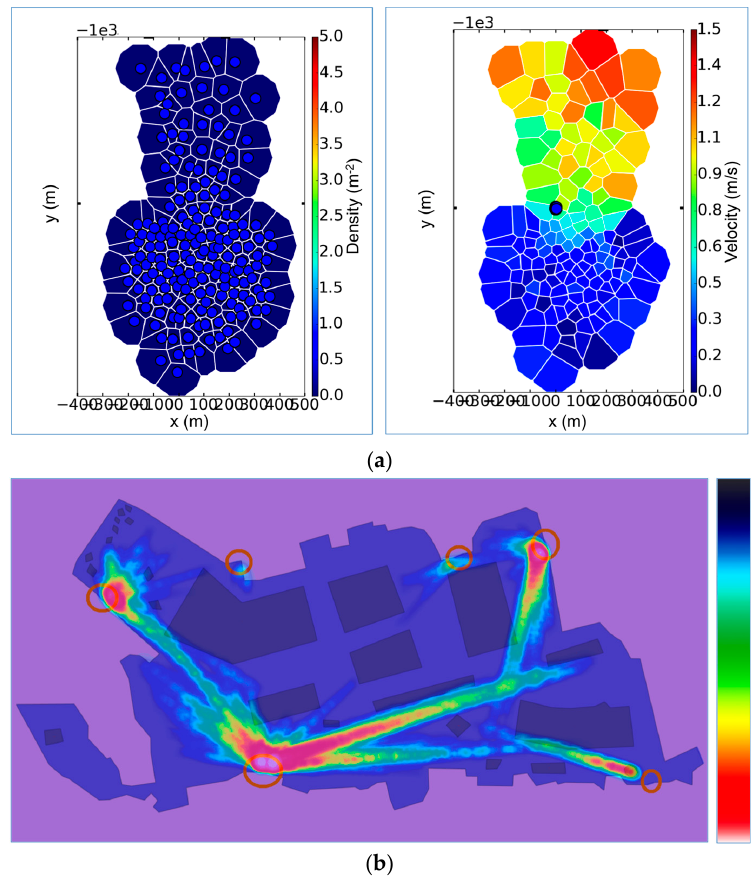
Figure 7. The output generated by the simulator: ( a ) two Voronoi diagrams for density and velocity of a portion of the map; and ( b ) the heat map generated by the simulation of an evacuation on the Paléo site (the orange circles indicate the exits).